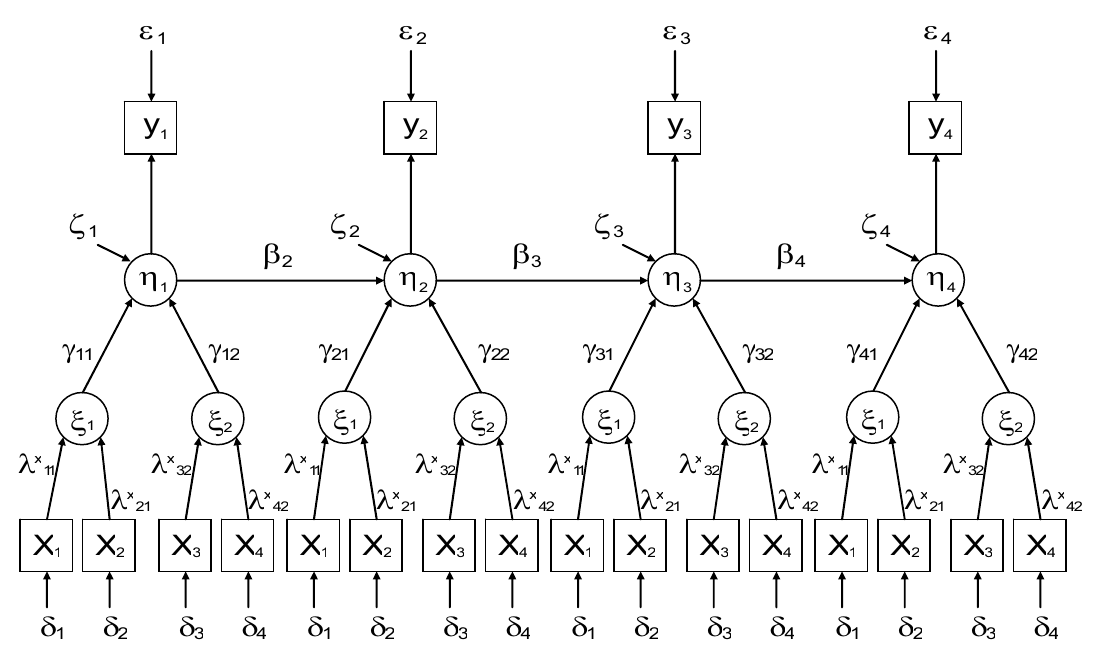
Figure 6 – The GENERAL SIMPLEX model path diagram.